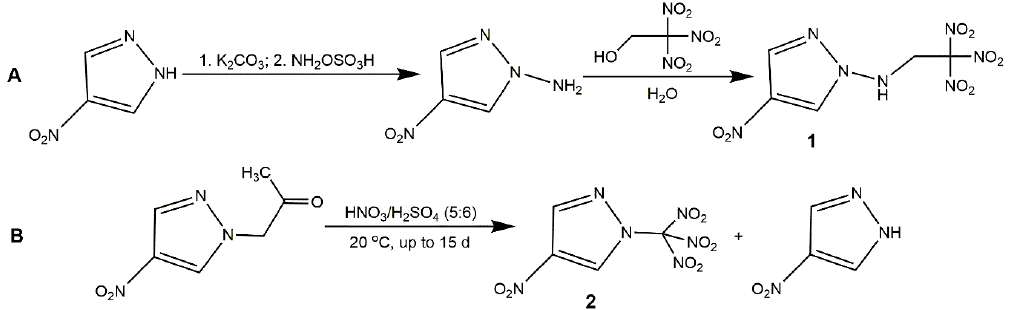
Figure 3. Synthesis of compounds 1 and 2 .